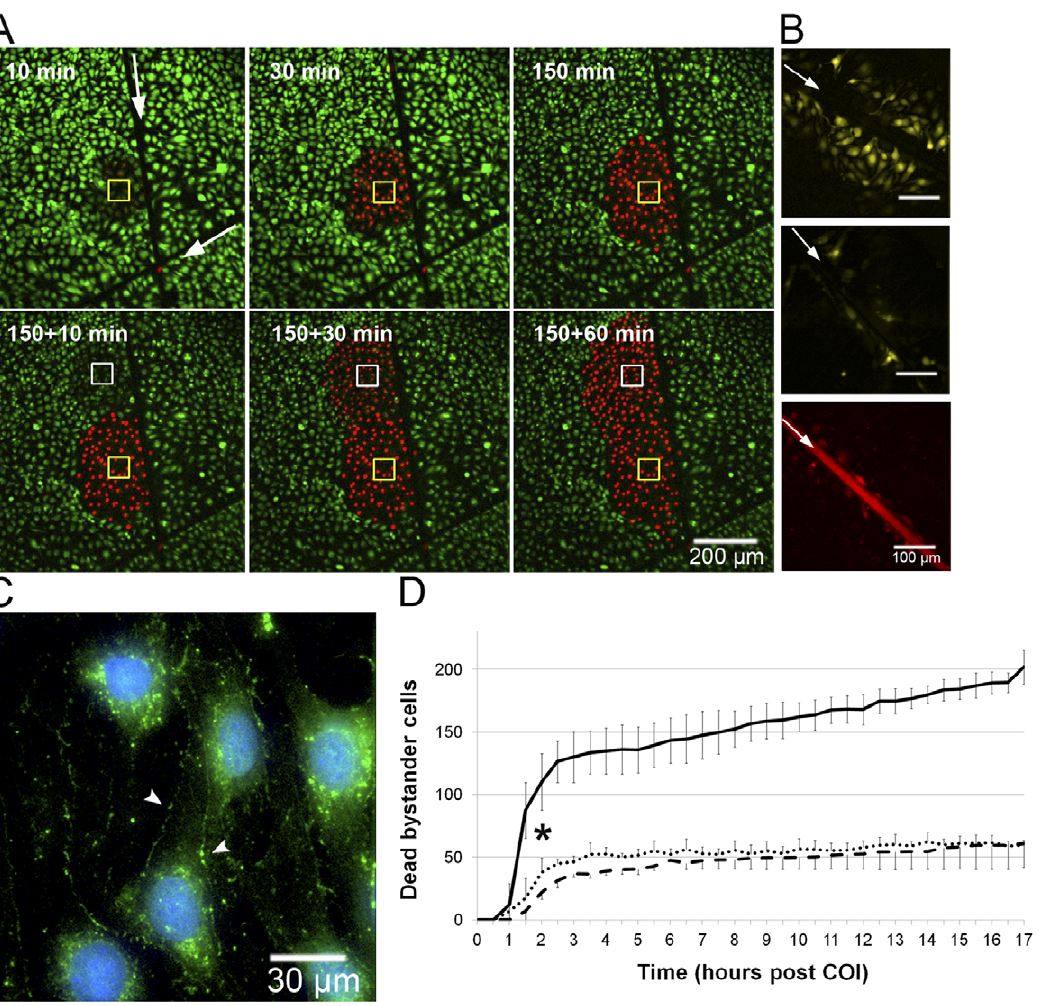
Figure 2. Death propagation among bystander cells requires cell-cell contact and connexins. A – Cell contact in bEnd.3 monolayer was impaired by surgical scalpel scratch (white arrows, scratch extends far beyond the field of view), and the culture was subjected to COI (60 6 60 m m, top left image, yellow rectangle) in one side of the scratch. Cell death (monitored as described in Fig. 1) propagates only in that side. Lower panel – an additional COI site was imposed at t=150 min in the same side of the scratch (white rectangle). B – bEnd.3 cells were incubated with GZA (inactive analog, upper panel) or the GJ uncoupler CBX (middle panel). After 30min Lucifer yellow (LY, pseudo yellow) was added and SLDT was carried out (n=12). White arrow marks the linear scratch. Rhodamine-dextran (red, lower panel) served as initial loading site control. C – bEnd.3 monolayers immunostained for Cx43, (pseudo-colored green) seen on cell membranes (arrow heads) and around the nuclei (counter stained with DAPI, pseudo- colored blue). Control experiments showed no non-specific binding of the secondary antibody (n=3). D – The graph illustrates time dependent registration of PI + cells beyond the COI rectangle in GZA treated (solid line), CBX treated (dashed line) and bEnd.3-D2 cells (dotted line) following COI. Values are displayed as means 6 SD. * P , 0.01 between the GZA and CBX/ bEnd.3-D2 experiments from t= . 1.5h onwards (n=4). All other details are described in Materials and Methods section.